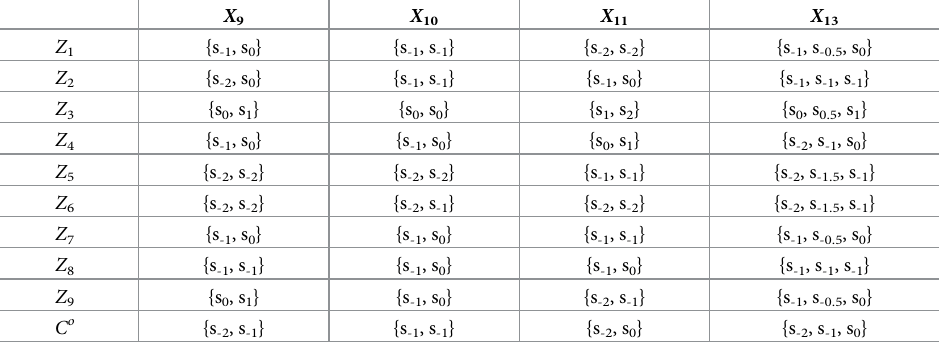
Table 4. A standardized decision